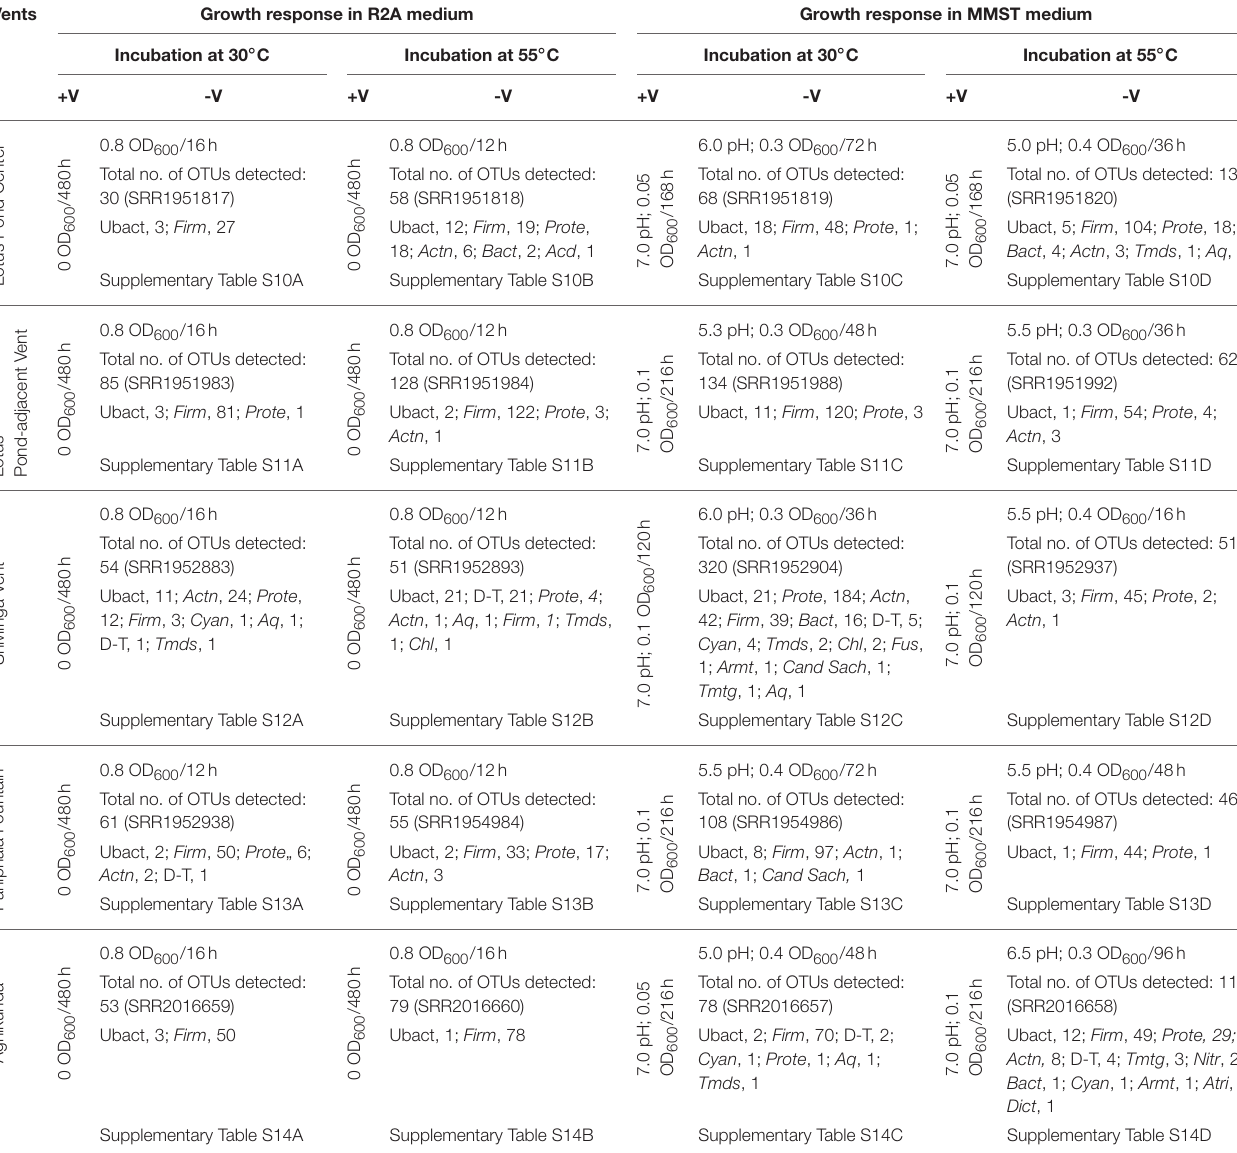
TABLE 2 | Bacterial taxonomic diversity detected after incubating vent water inocula in R2A or MMST medium.